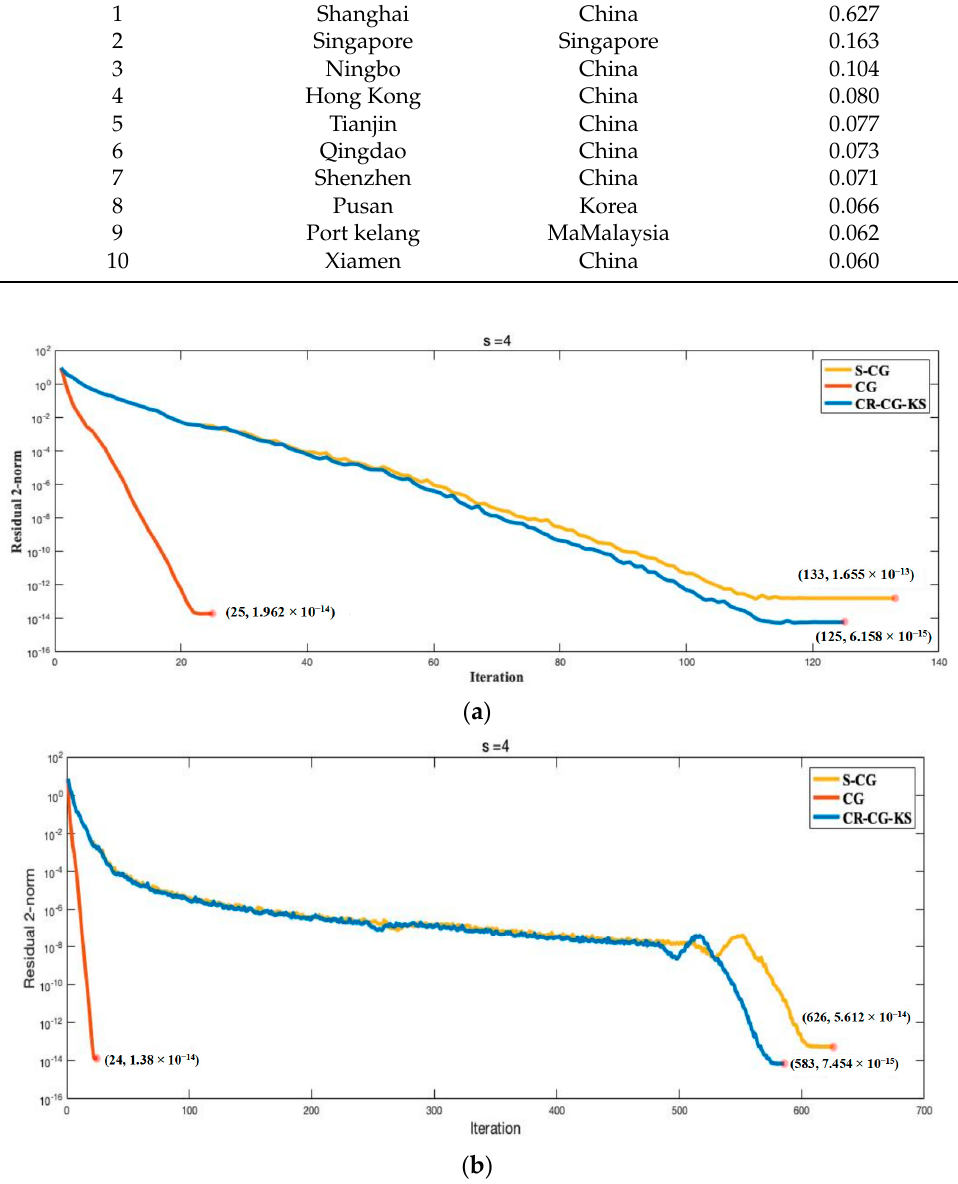
Figure 6. Algorithm iterative process comparison: ( a ) S = 4, 237 ports ( b ) S = 4, 625 ports.